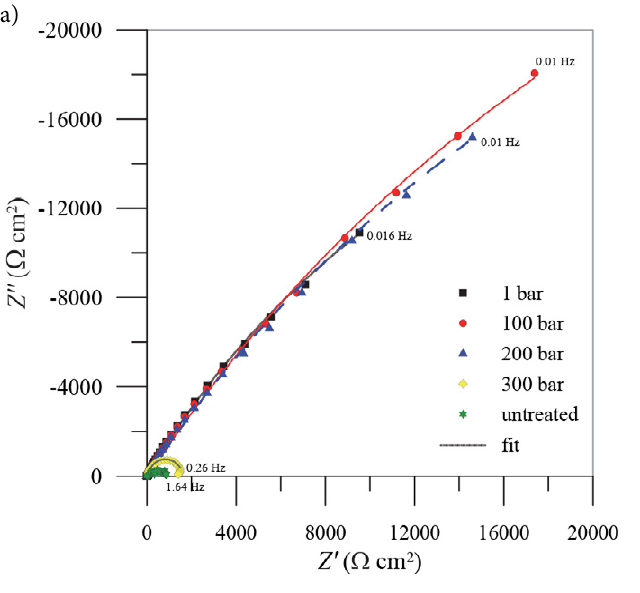
Figure 7. Impedance spectra for AISI 347 at 75 °C: a) Nyquist plot, b) and c) Bode plot Table 1. Parameter values from EIS measurements for AISI 347 at 50 and 75 °C.